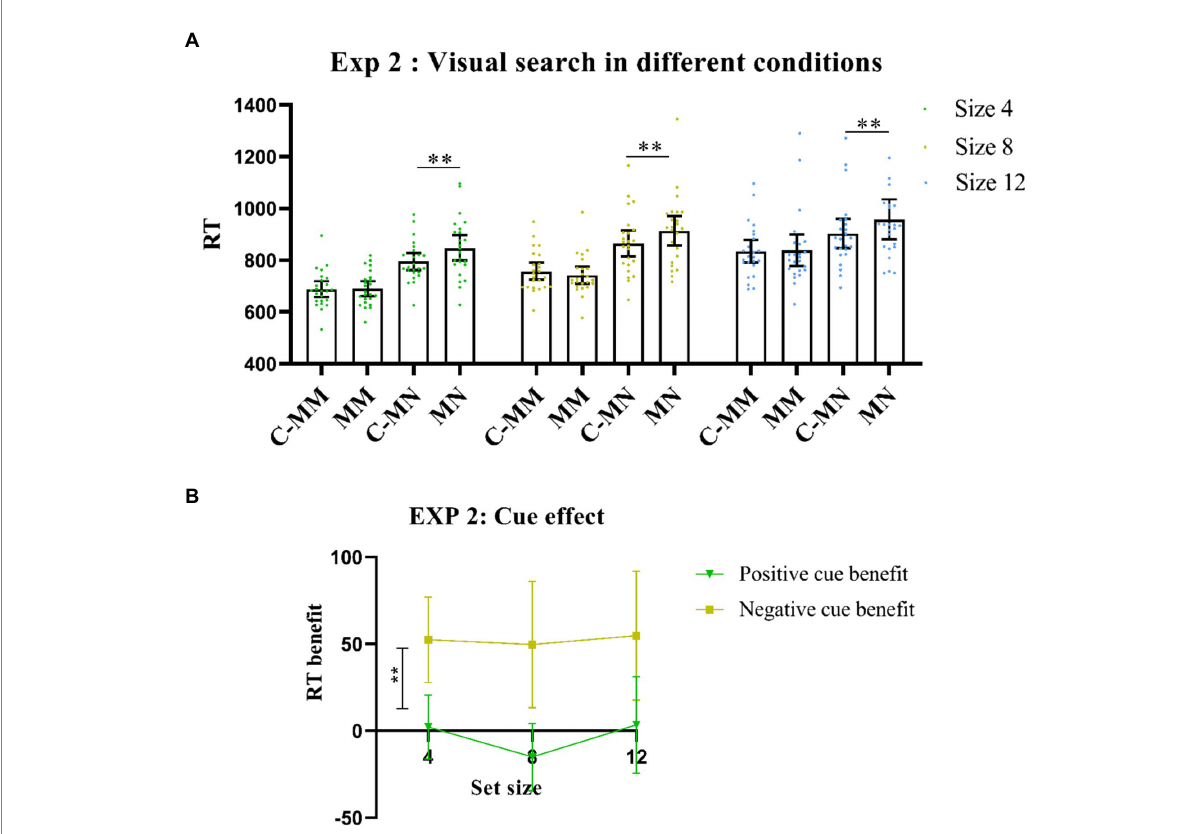
FIGURE 3 (A) Visual search performance in all Experiment 2 conditions. MM: memory-item-target-match; MN: memory-item-non-target-match; C-MM: cue-memory-item-target-match; CMN: cue-memory-item-non-target-match. ** p < 0.001. Error bars represent 95% within- subjects confidence intervals, as described by Loftus and Loftus (1988). (B) Cue benefit in Experiment 2. ** p < 0.001. Error bars represent 95% within-subjects confidence intervals, as described by Loftus and Loftus (1988). Positive cue benefit = MM-CMM (RT); Negative cue benefit = MN-CMN